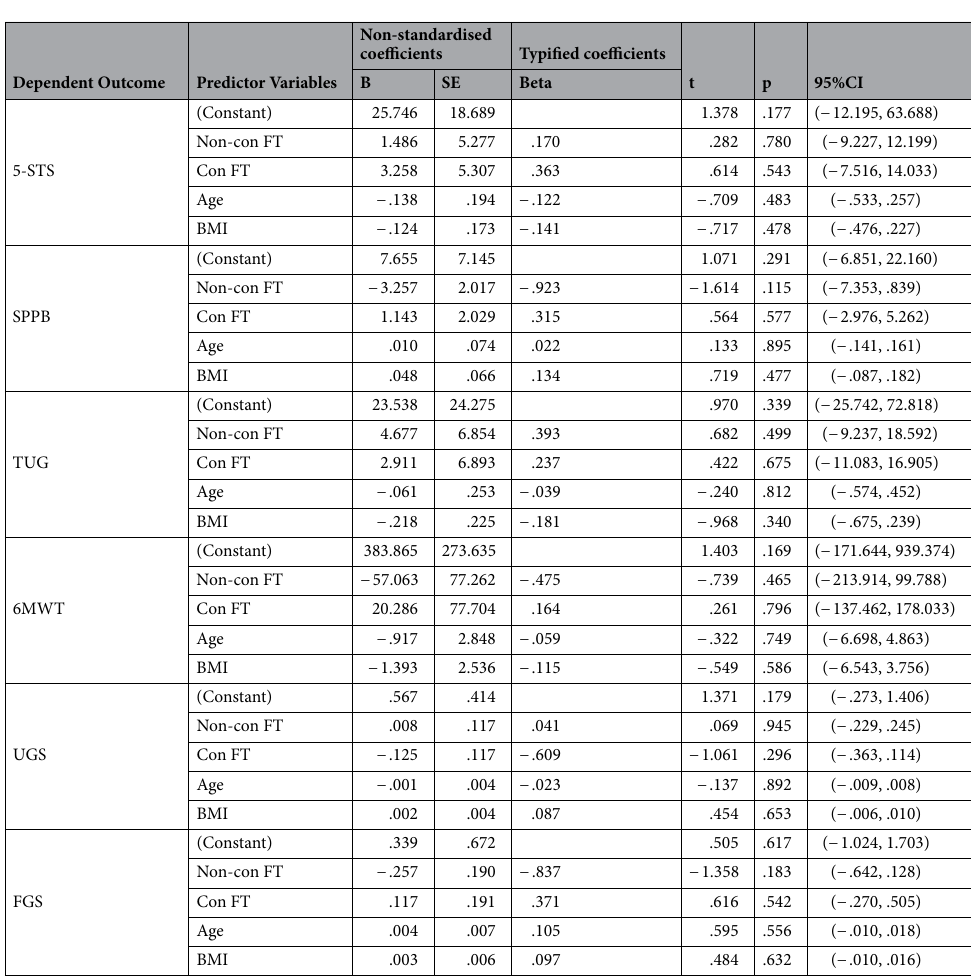
Table 3. Multivariate linear regression models in women, adjusted by age and